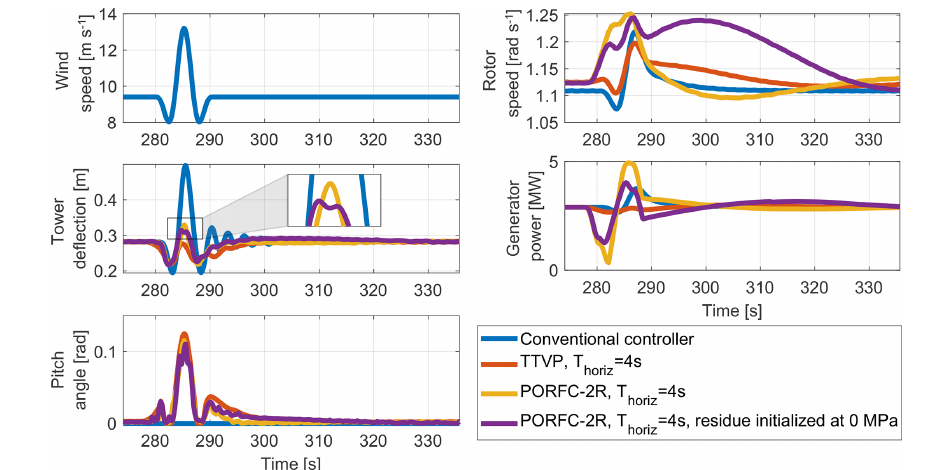
Figure 17. Extreme operating gust at V = V rated − 2ms − 1